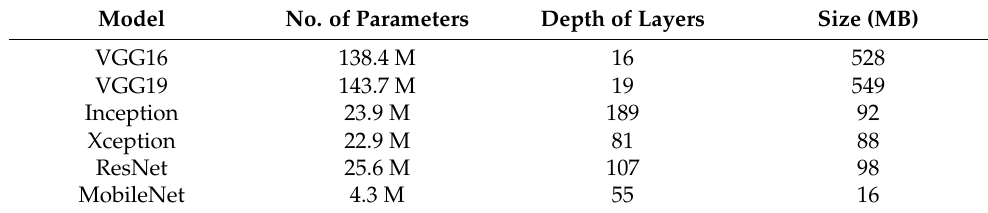
Table 4. Comparison of proposed pre-trained CNN models.